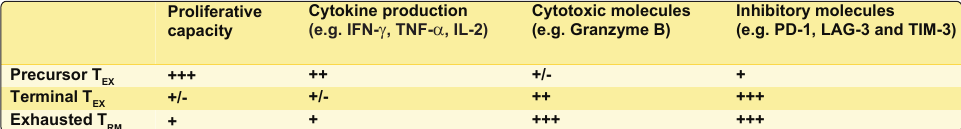
Figure 1. The differentiation pathway of exhausted T cells and tissue-resident memory T cells in the tumor microenvironment. ( A ) Upon activation, precursor exhausted T (T EX ) cells expressing the surface molecules SLAMF6, CXCR5 and CD69 and the transcription factors TCF-1 and T-BET migrate from the T cell zones of the secondary lymphoid organs (SLO) towards the tumor microenvironment (TME). ( B ) In the TME, precursor T EX differentiate into terminal T EX , which express the transcription factors TOX, BLIMP-1, Eomes and NR4A, and have an impaired ability to produce cytokines (e.g., IFN- γ , TNF- α and IL-2), but an increased production of cytotoxic molecules (e.g., granzyme B). Terminal T EX also upregulate the expression of inhibitory receptors, such as PD-1, CTLA-4, LAG-3 and TIM-3. Precursor T EX may also give rise to intratumoral tissue-resident memory T (T RM ) cells expressing the transcription factors BLIMP-1, HOBIT and RUNX3 and the extracellular molecules CD69, CD103 and CD49a. Similar to terminal T EX , T RM upregulate inhibitory receptors and downregulate cytokine responses. In contrast, T RM appear to maintain expression of cytotoxic molecules. Abbreviations: BLIMP-1, B lymphocyte-induced maturation protein 1; CTLA-4, cytotoxic T-lymphocyte-associated protein 4; CX3CR1, CX3C chemokine receptor 1; CXCR5, C-X-C chemokine receptor type 5; GZMB, granzyme B; HOBIT, homolog of Blimp-1 in T cells; IFN- γ , interferon gamma; IL-2, interleukin 2; LAG-3, lymphocyte-activation gene 3; NR4A, nuclear hormone receptor 4A; PD-1, programmed cell death protein 1; PRF1, perforin 1; RUNX3, runt-related transcription factor 3; SLAMF6, SLAM family member 6; T-BET, T-box transcription factor 21; TCF-1, T-cell factor 1; TIM-3, T-cell immunoglobulin and mucin domain 3; TNF- α , tumor necrosis factor alpha; TOX, thymocyte selection-associated high-mobility group box